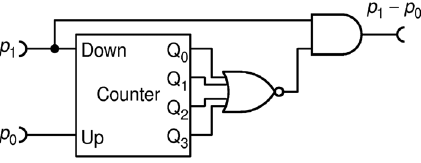
Figure 20. A simple and precise subtraction circuit SUB3 with counter of N = 4 bits.